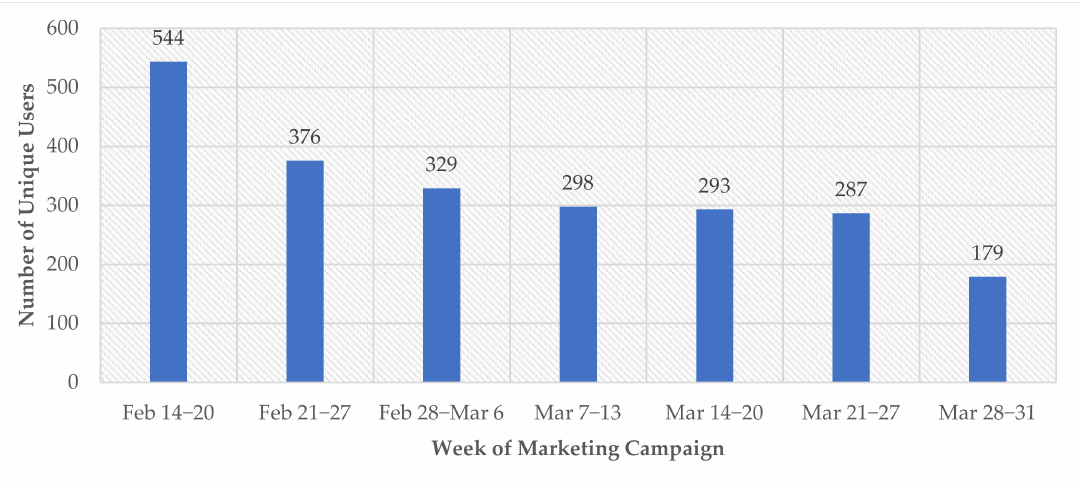
Figure 3. Number of users visiting the Tobacco Fact or Fiction tool per week for the 7-week marketing campaign ( n =